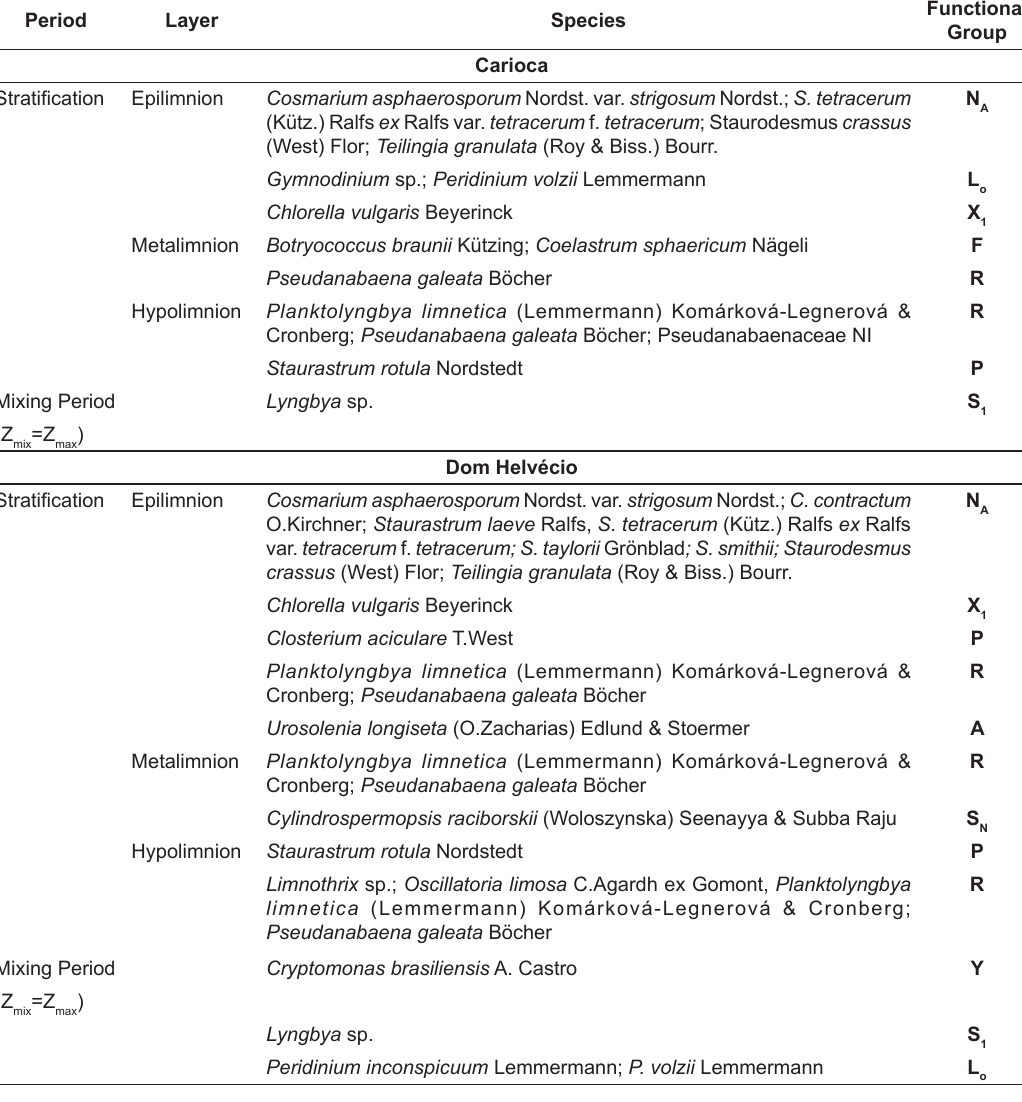
Table 3. Phytoplankton functional groups for Carioca and Dom Helvécio lakes between 2002-2006.